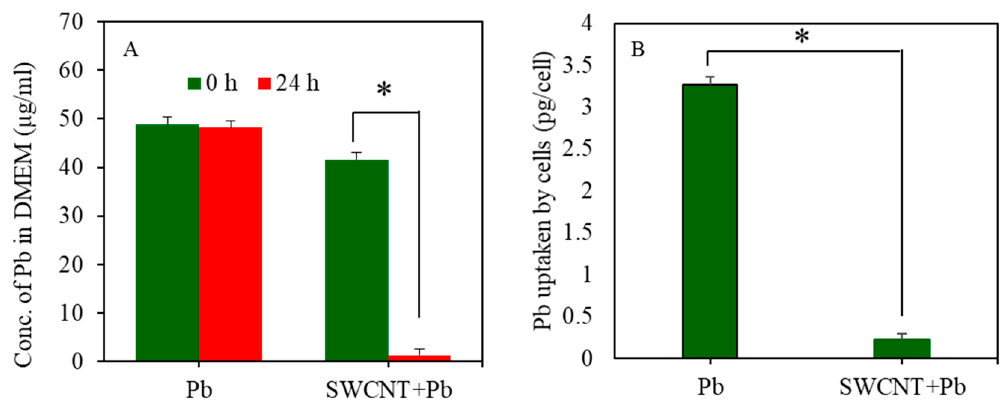
Figure 6. ICP-MS analysis. ( A ) Significant amount Pb present in co-exposure group (SWCNTs + Pb) was adsorbed on the surface of SWCNTs (* p < 0.05). ( B ) Significant difference in uptake of Pb by A549 cells between Pb group and co-exposure group (SWCNTs + Pb) (* p < 0.05). Pb uptake by cells